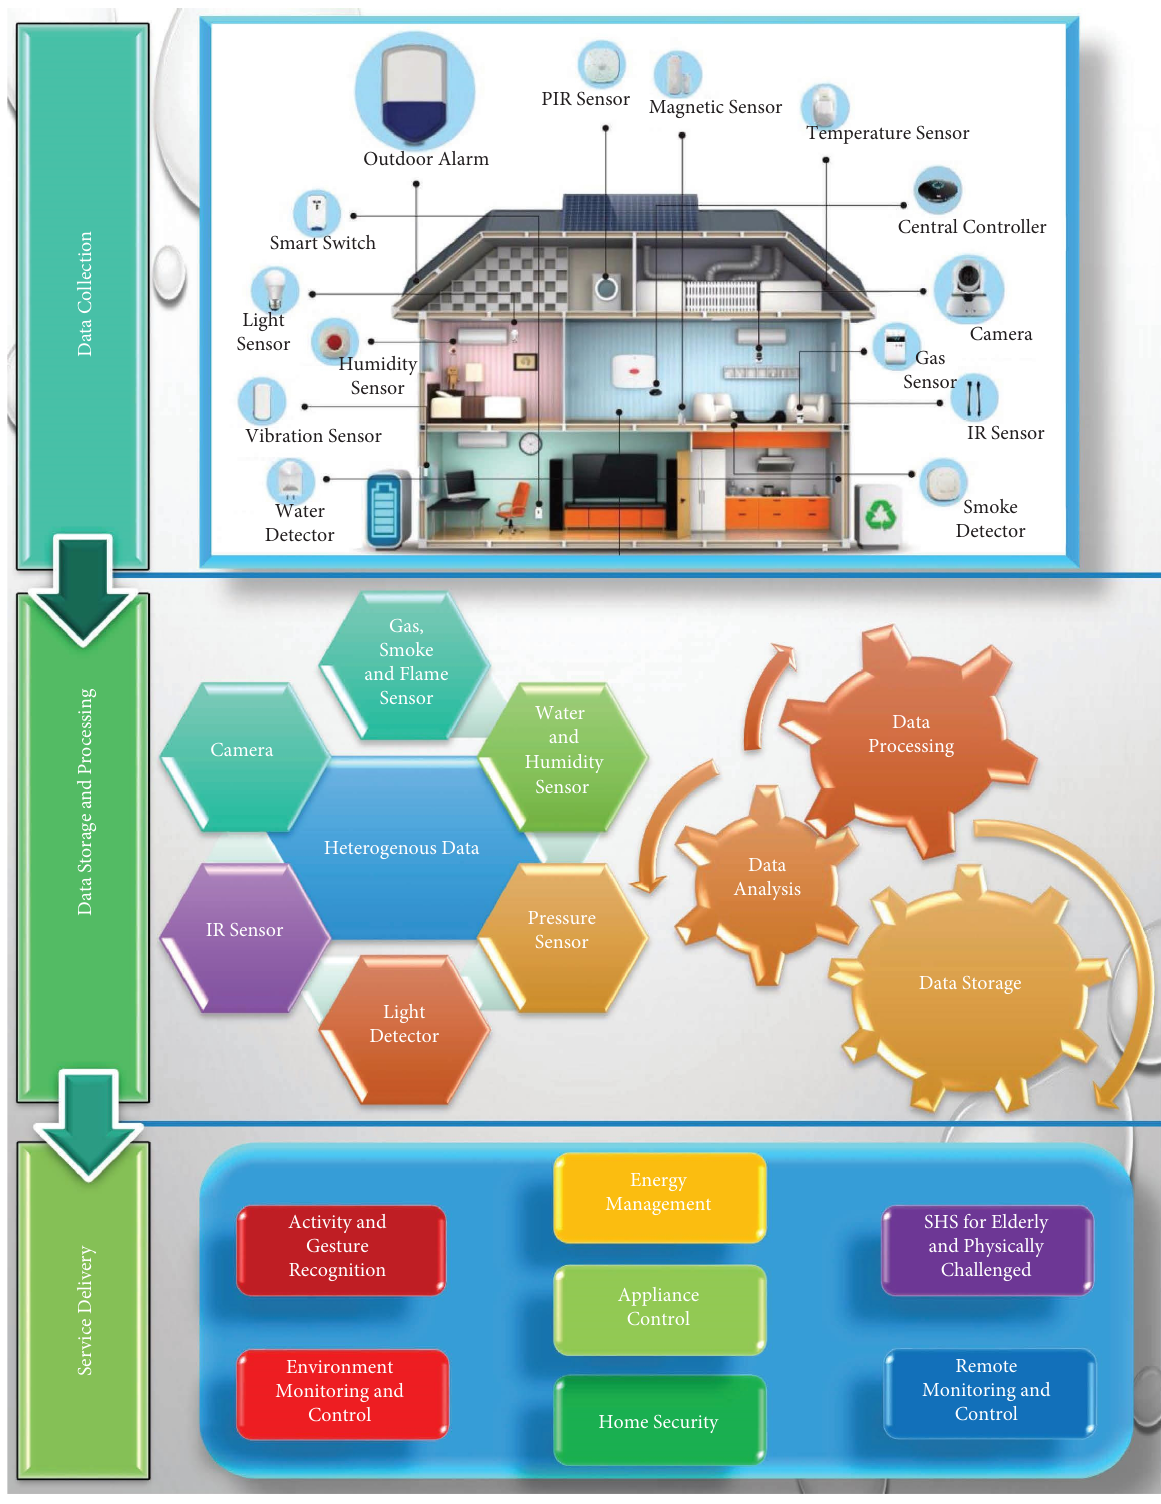
Figure 7: Smart home